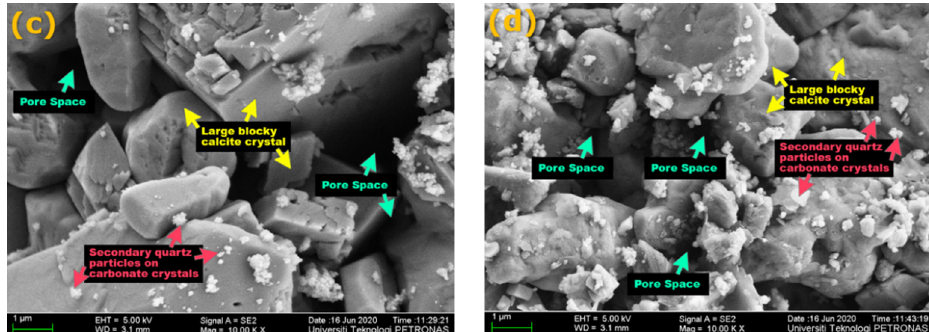
Figure 16. FESEM image showing the presence of micro-pores of sample ( a ) A-1.1, ( b ) A-1.2, ( c ) A-1.3 and ( d ) A-1.4.